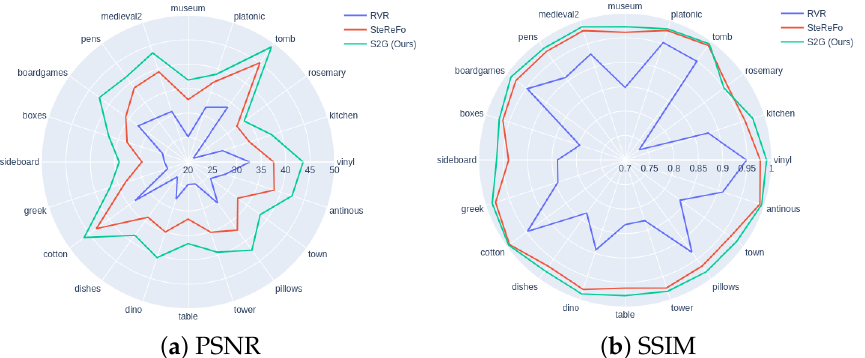
Figure 10. The radar charts summarize the scores on different